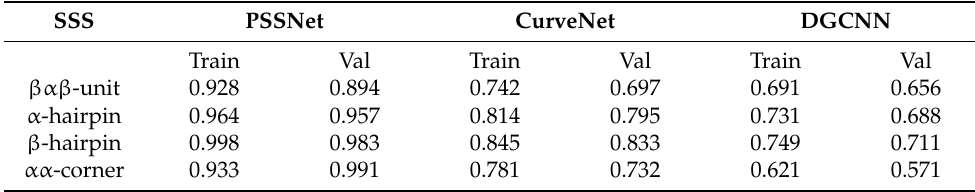
Table 2. Comparison between our proposed and other models (mean